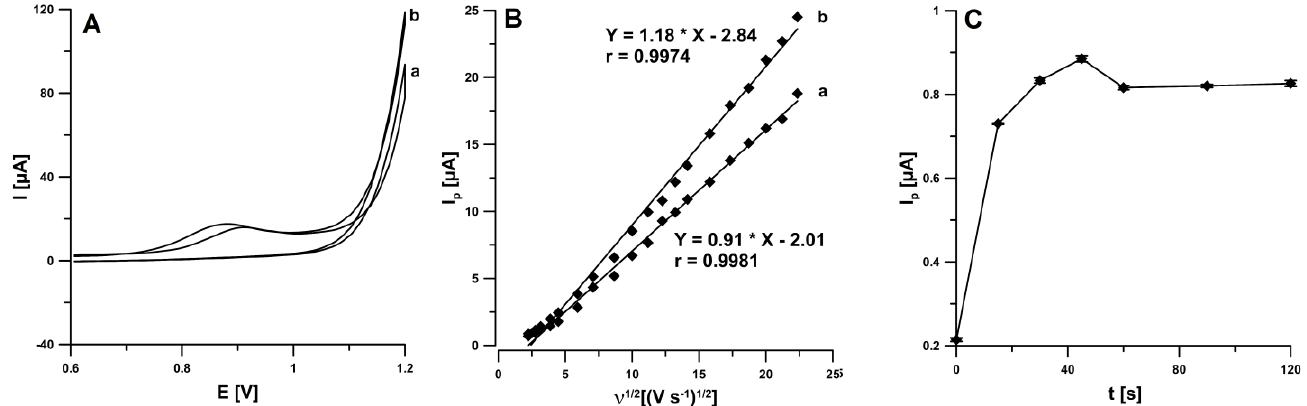
Figure 1. ( A ) CVs recorded in 0.25 M acetate buffer solution of pH 4.5 ± 0.1 containing 0.1 mM IBP at scan rate of 100 mV s − 1 (a—5 s, b—60 s), ( B ) the dependence between I p and ν 1/2 for ν from 5 to 500 mV s − 1 (a—5 s, b—60 s), ( C ) effect of solution stirring time on the analytical signal of 20.0 µM IBP.